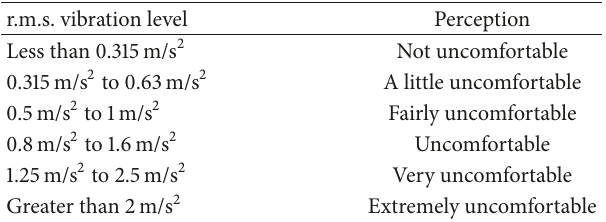
Table 8: Limit values of the ISO coefficient (taken from [20]).